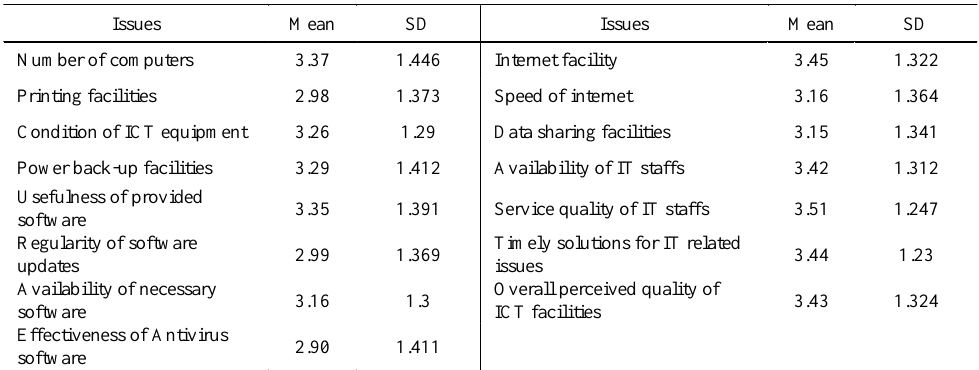
Table 2: Summary of